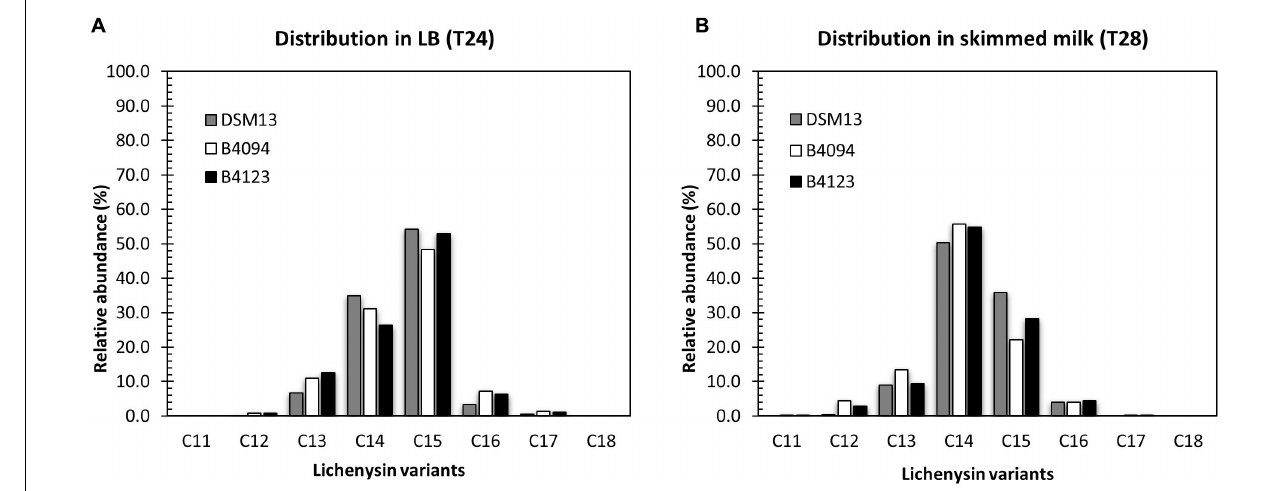
FIGURE 4 | Distribution of lichenysin A variants, produced in LB broth and skimmed milk at 37 ◦ C. Relative abundance of individual lichenysin variants as part of the total amount in (A) - LB broth at 24 h; (B) skimmed milk at 28 h. Gray bar- DSM13 T , white bar- B4094, black bar- B4123.